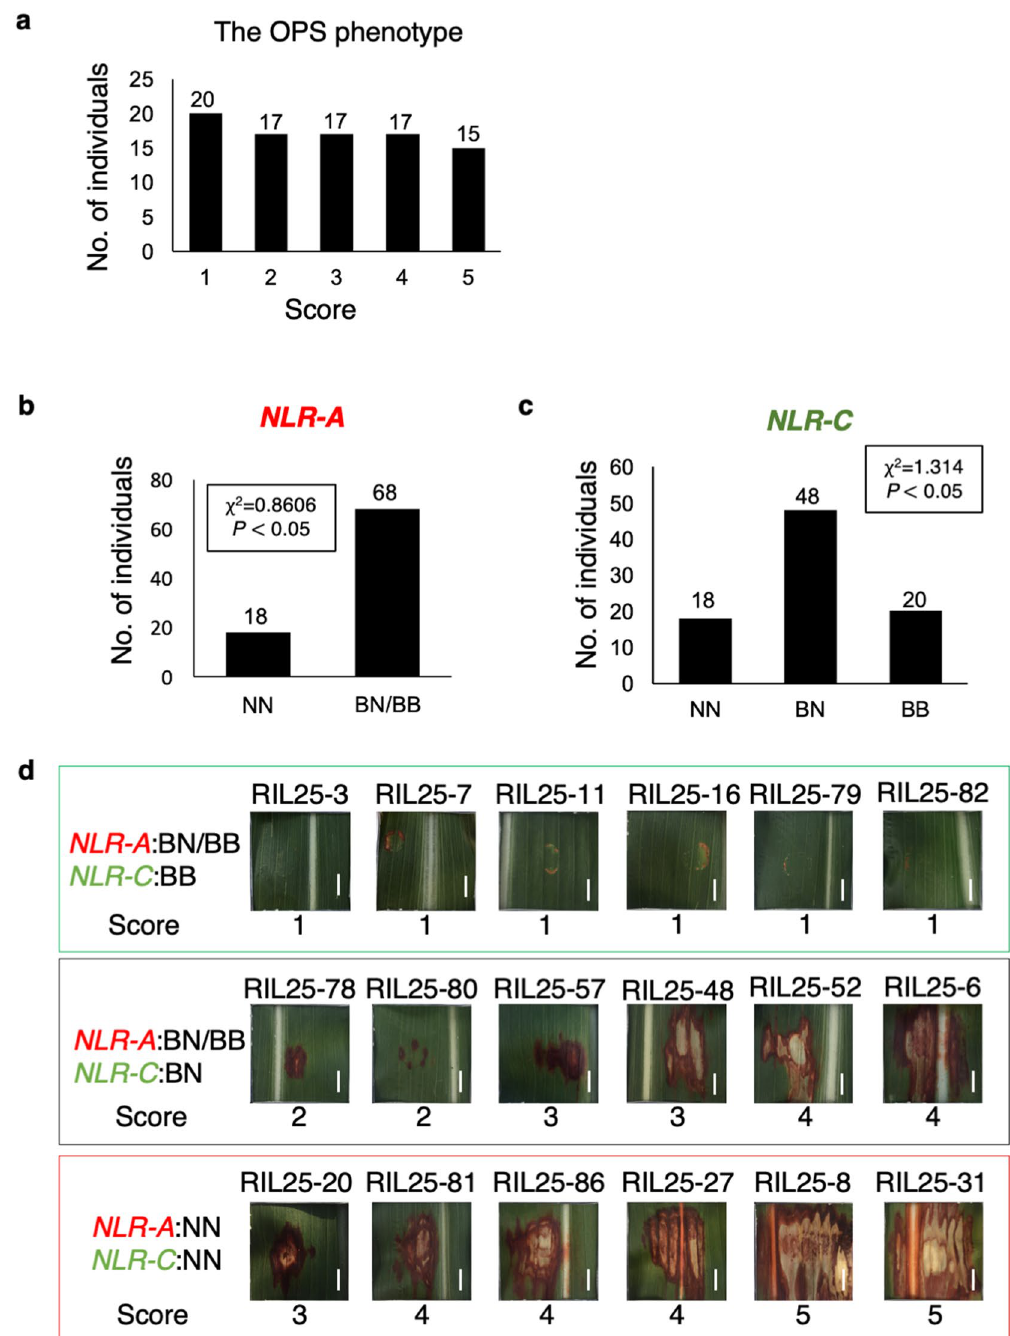
Figure 5. Linkage analysis of OPS with NLR-C in the RIL25-F 9 segregating population. ( a ) Histogram of 86 individuals subjected to segregation analysis. The Y axis represents numbers of individuals and the X axis represents the scores, a score of 1 indicates resistance to OP treatment, whereas a score of 5 indicates sensitivity. ( b ) Segregation of NLR-A genotypes among F 9 individuals showing a 1:3 ratio ( P < 0.05, χ 2 = 0.8606). ( c ) Segregation of NLR-C genotypes among F 9 individuals showing a 1:2:1 ratio ( P < 0.05, χ 2 = 1.314). ( d ) Representative images of OPS phenotypes in the corresponding genotypes. The genotype of the OSR locus is indicated on the left, and the OPS phenotypes from individuals homozygous for BTx623 (top), heterozygous (middle), and homozygous for NOG (bottom) are shown. Scale bars; 0.6